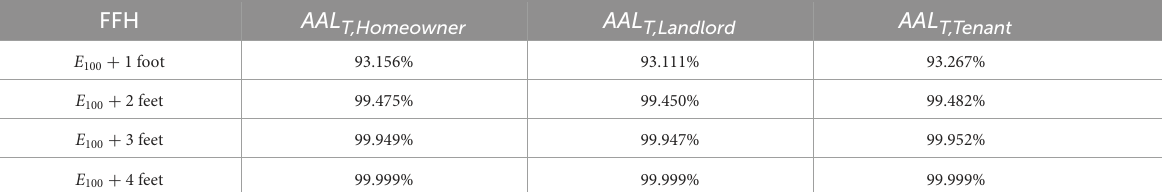
TABLE 4 AAL T reduction by combination of increases in FFH above 100-year flood elevation and owner/occupant type.